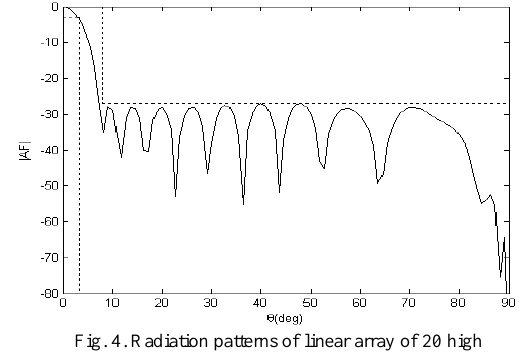
Fig. 4. Radiation patterns of linear array of 20 high superconducting rectangular microstrip antennas with: